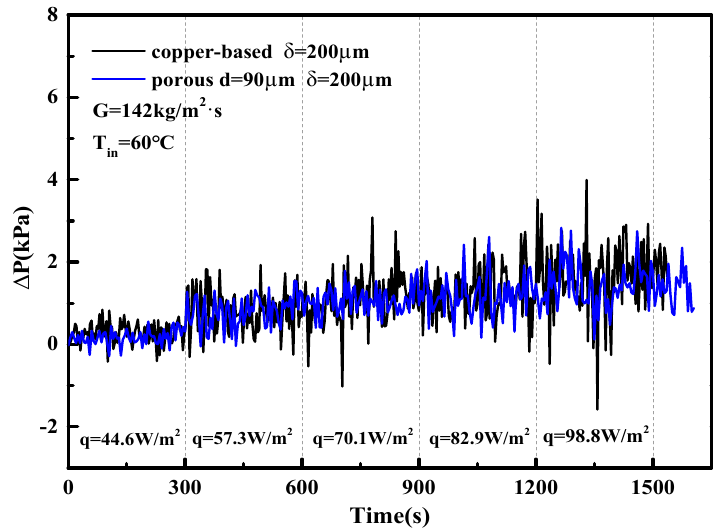
Figure 10. The pressure drop fluctuation of the porous microchannel versus copper-based microchannel.